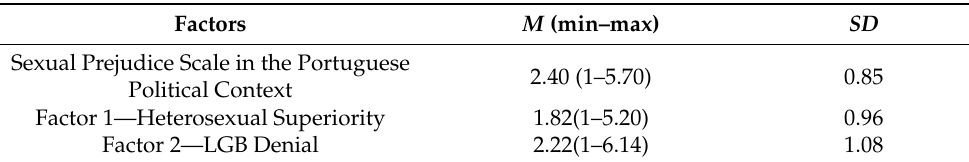
Table 2. Sexual Prejudice Scale in the Portuguese political context (SPSPPC) and Factors 1 and 2 score